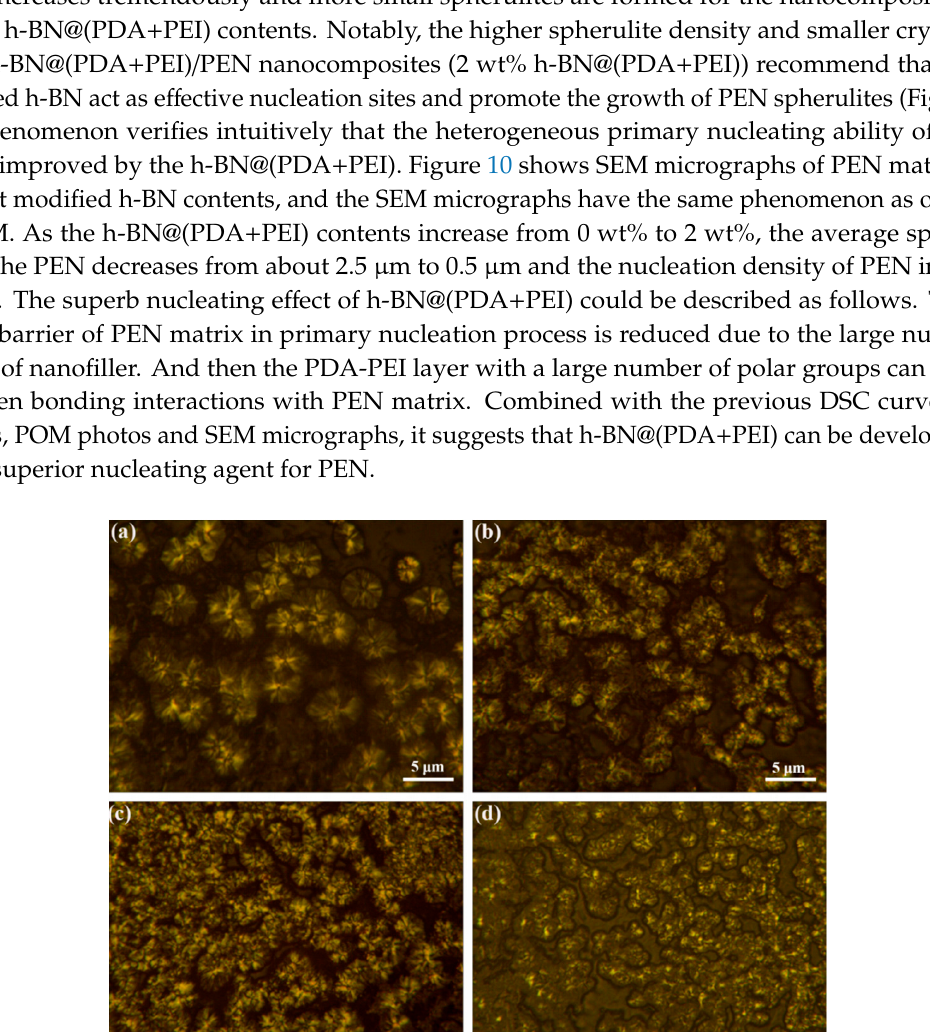
Figure 10. SEM micrographs of the cross-section of the nanocomposites with different h- BN@(PDA+PEI) contents: ( a ) 0 wt%; ( b ) 0.5 wt%; ( c )1 wt%; ( d ) 2 wt% isothermal crystallization at 260 °C for 2 h, respectively. 3.4. Mechanical and Dielectric Properties of h-BN@(PDA+PEI)/PEN Nanocomposite Films To further explore the influence of functionalized h-BN on the properties of PEN composite films, the mechanical properties of them are investigated and shown in Figure 11. As depicted in Figure 11a,b, the same fluctuation trend can be observed in both the tensile strength (T S ) and modulus (T M ), which increase significantly at low mass fraction of functionalized h-BN and reach a maximum value of 136.1 MPa and 2623.2 MPa with 2 wt%, respectively, indicating the increment of 9% and 7% compared with pure PEN film (124.6 MPa and 2448.5 MPa). The improvements of T S and T M are ascribed to the even dispersion of functionalized h-BN in the PEN matrix through strong polar interaction. However, the elongation at break (E b ) of the nanocomposites gradually increases and